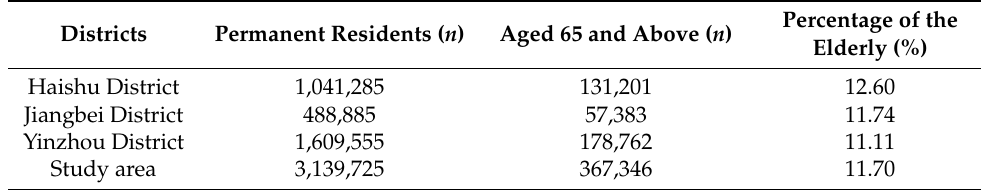
Table 1. Summary of the elderly (aged 65 and above) in Study area,